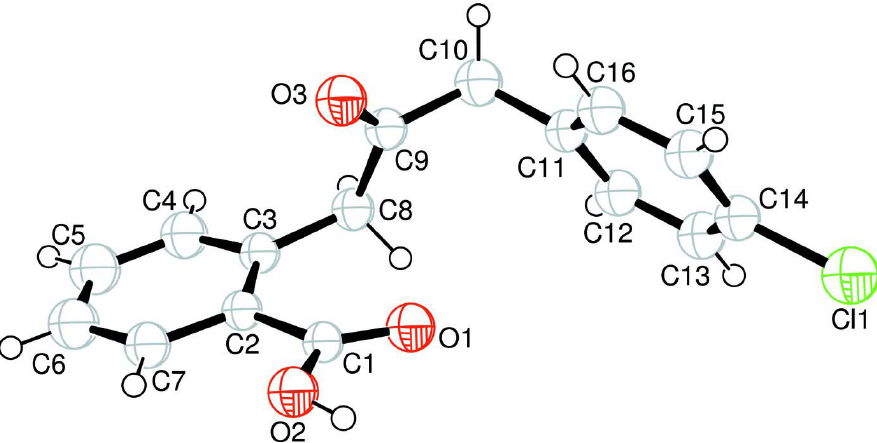
Figure 1 The molecular structure of the title molecule, with the atom-numbering scheme.